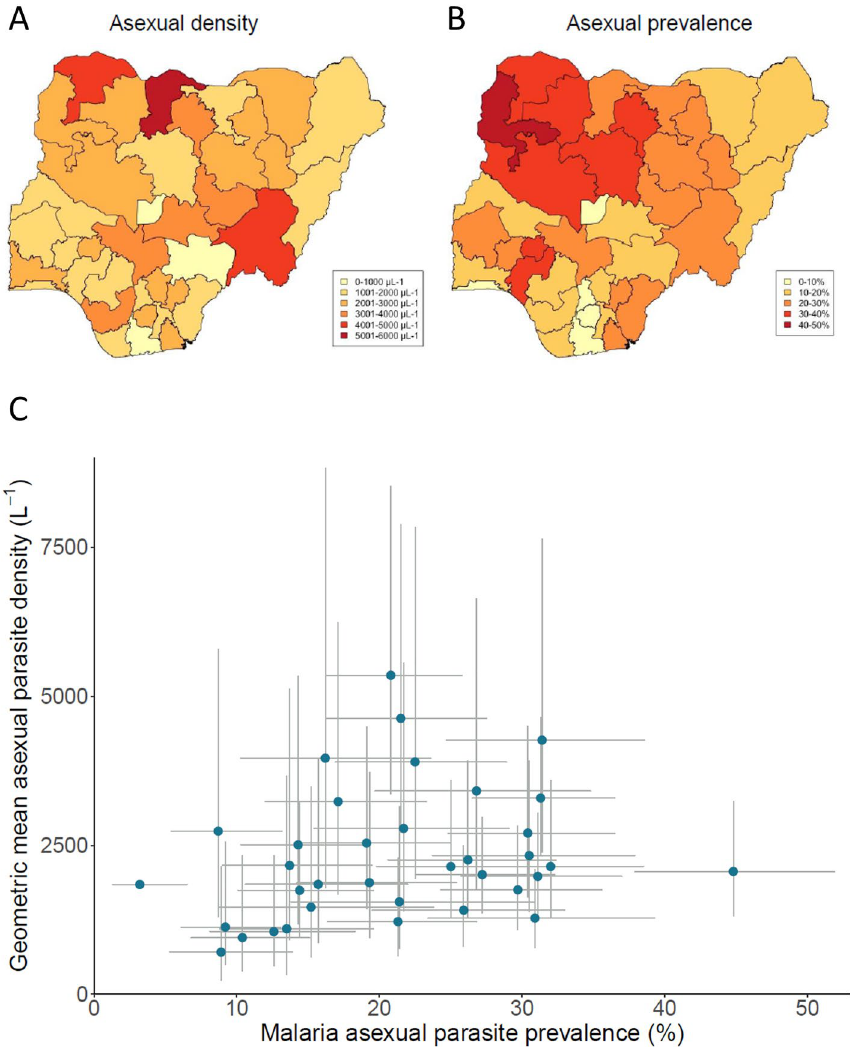
Figure 2. Geographical variation in mean malaria parasite density in infected children up to 5 years of age in Nigeria. ( A ) Variation in geometric mean parasite density among all 36 states, with densities shaded by value categories as indicated. The names of individual states are shown in Fig. 1, and numerical values (with 95% CIs of estimates) are tabulated in Supplementary Table S1. ( B ) Prevalence of malaria parasite infection in each of the states, shaded by value categories as indicated and previously analysed 6 . ( C ) Scatterplot showing a positive significant correlation between asexual parasite prevalence and density within infections in each state in Nigeria. Lines indicate the 95% CI for the density and prevalence for each state (a point on the far left corresponds to Lagos which does not show 95% CI for density as there were too few samples positive for accurate estimation). All values are shown in Supplementary Table